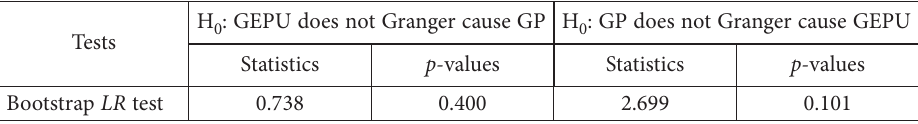
Table 2. Full-sample Granger causality